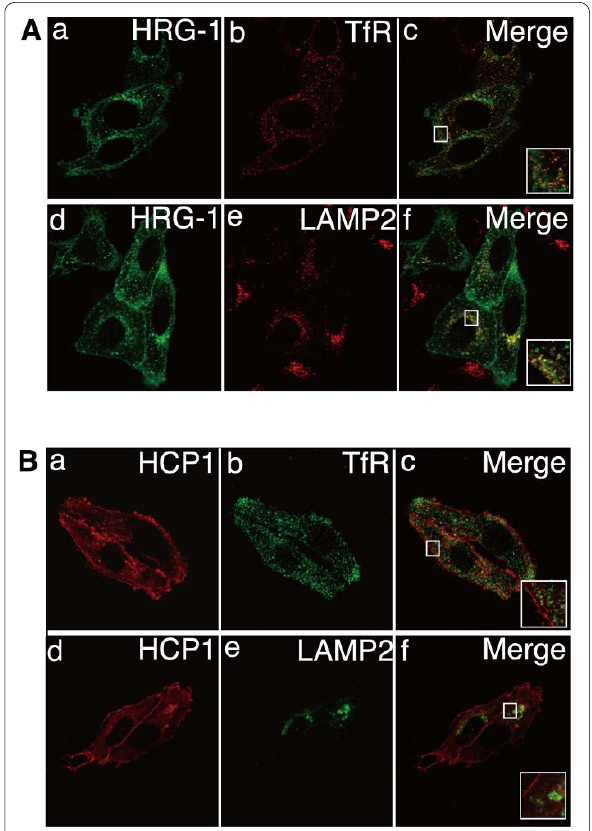
Figure 3 Subcellular localizations of HRG-1 and HCP1 in HEp-2 cells . A. GFP-tagged HRG-1 was transfected into HEp-2 cells. The cells were fixed and stained with antibodies against GFP (a and d), TfR (b), and LAMP2 (e). B. mCherry-tagged HCP1 was transfected into HEp-2 cells. The cells were fixed and stained with antibodies against mCherry (a and d) TfR (b), and LAMP2 (e). Each inset shows a higher magnifica- tion image of the boxed